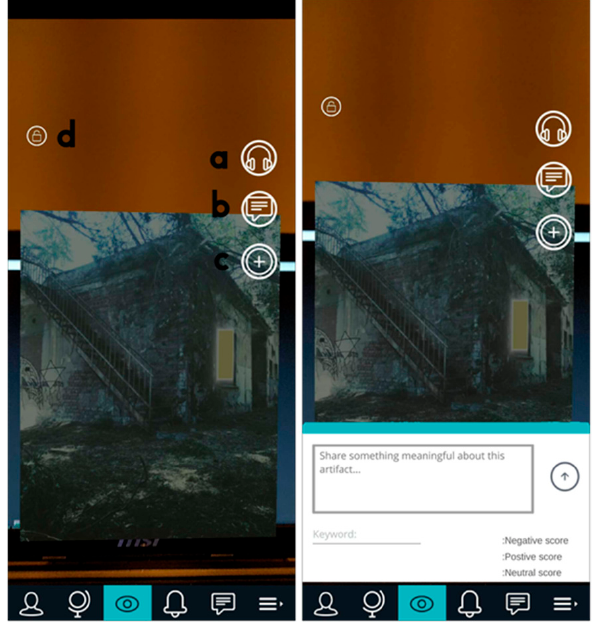
Figure 11. The left picture presents the AR menu appearing when an exhibit is targeted by the device’s camera. It includes the following options: ( a ) the headphones button for listening to the expert’s commentary, ( b ) the messages button for reading/listening to and interacting with other visitors’ posts, ( c ) the addition button in case a user would like to offer their own comment about the exhibit completing the form presented in the right picture, and ( d ) the keywords button for selecting keywords of most popular visitors’ posts regarding that exhibit.